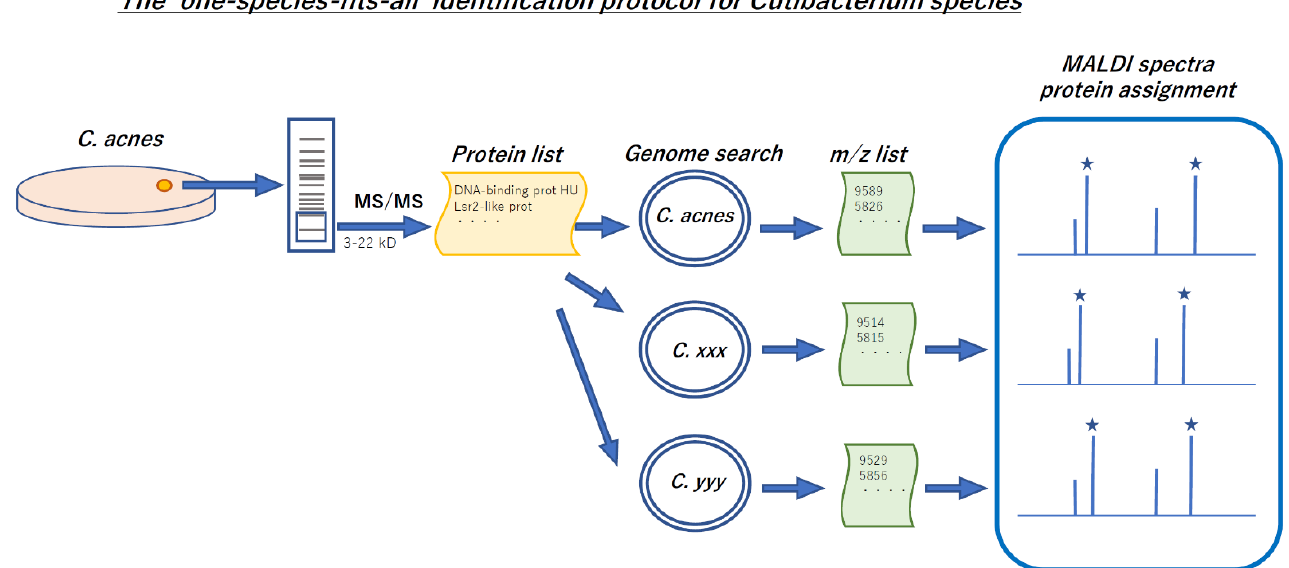
Figure 2. Scheme of the experimental flow for Cutibacterium MALDI peaks.